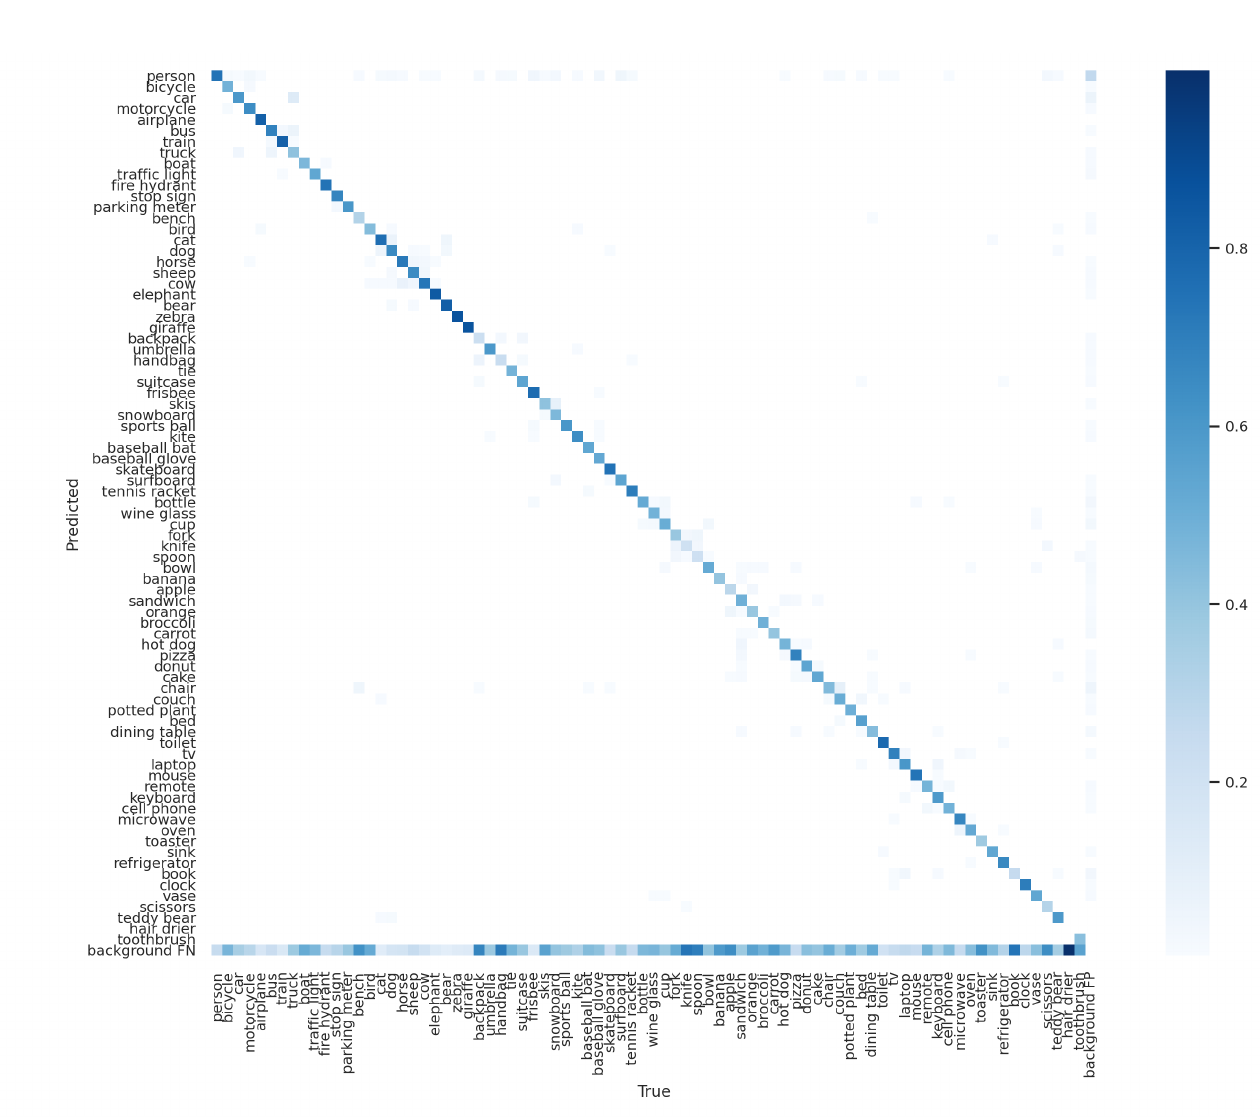
Figure 7. Confusion matrix among 80 classes of the searched